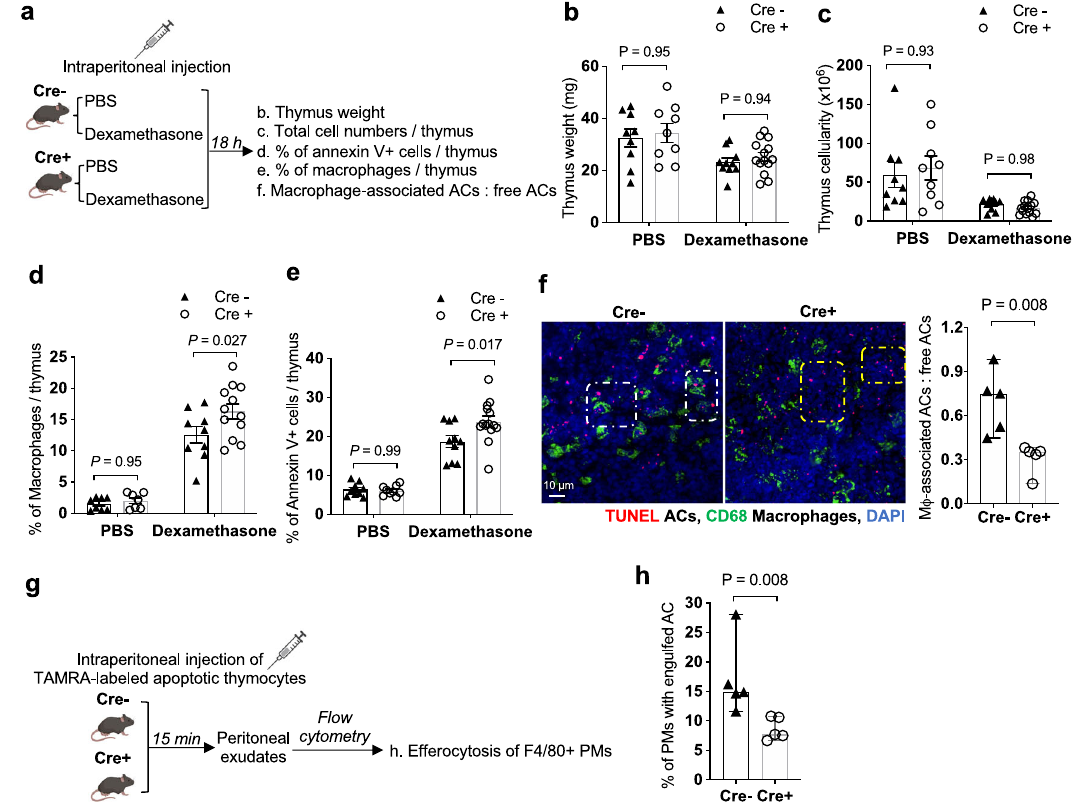
Fig.5|Micewithmyeloid Wdfy3 knockoutshowimpairedefferocytosisinvivo. a Schematics of experimental design for in vivo thymus efferocytosis assay. b Thymus weight. c Total number of cells per thymus. d Percentage of F4/80 + macrophages in the thymus determined by fl ow cytometry. e Percentage of Annexin V + ACs per thymus determined by fl ow cytometry. A higher percentage implies impaired efferocytic clearance. f Thymicsectionswerestained with TUNEL for ACs, and CD68 for macrophages. The ratio of macrophage-associated TUNEL + cells vs. free TUNEL + cells was quanti fi ed and summarized. The white and yellow squares highlight the macrophage-associated and free TUNEL + cells, respectively ( n =5 biological replicates). g Schematics of experimental design for in